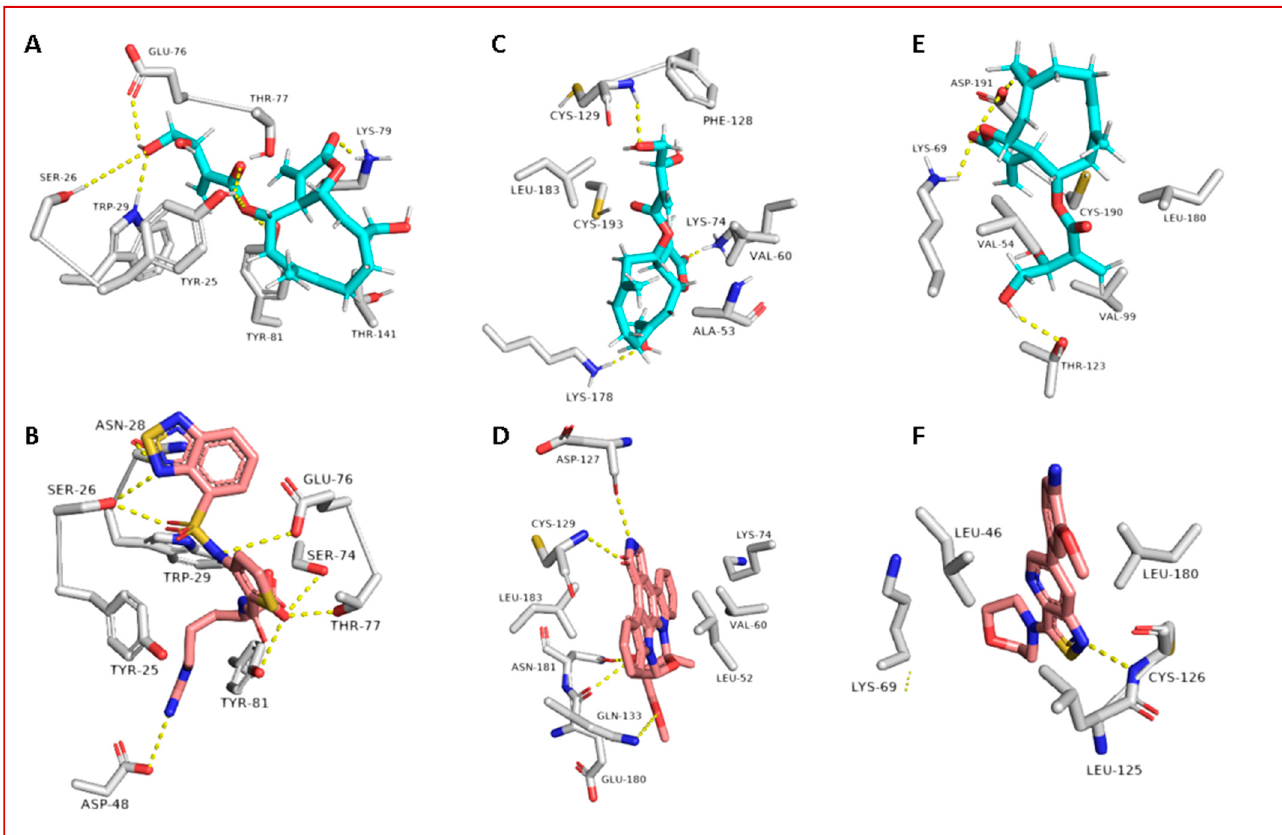
Figure 11. Binding modes of cnicin inside the binding sites of three human targets involved in viral entry—NRP-1, AAK1, and GAK ( A , C , and E , respectively)—during 100 ns of MDS (i.e., the last snapshots of the simulations), along with the binding modes of the corresponding co-crystallized ligands ( B , D , and F , respectively).